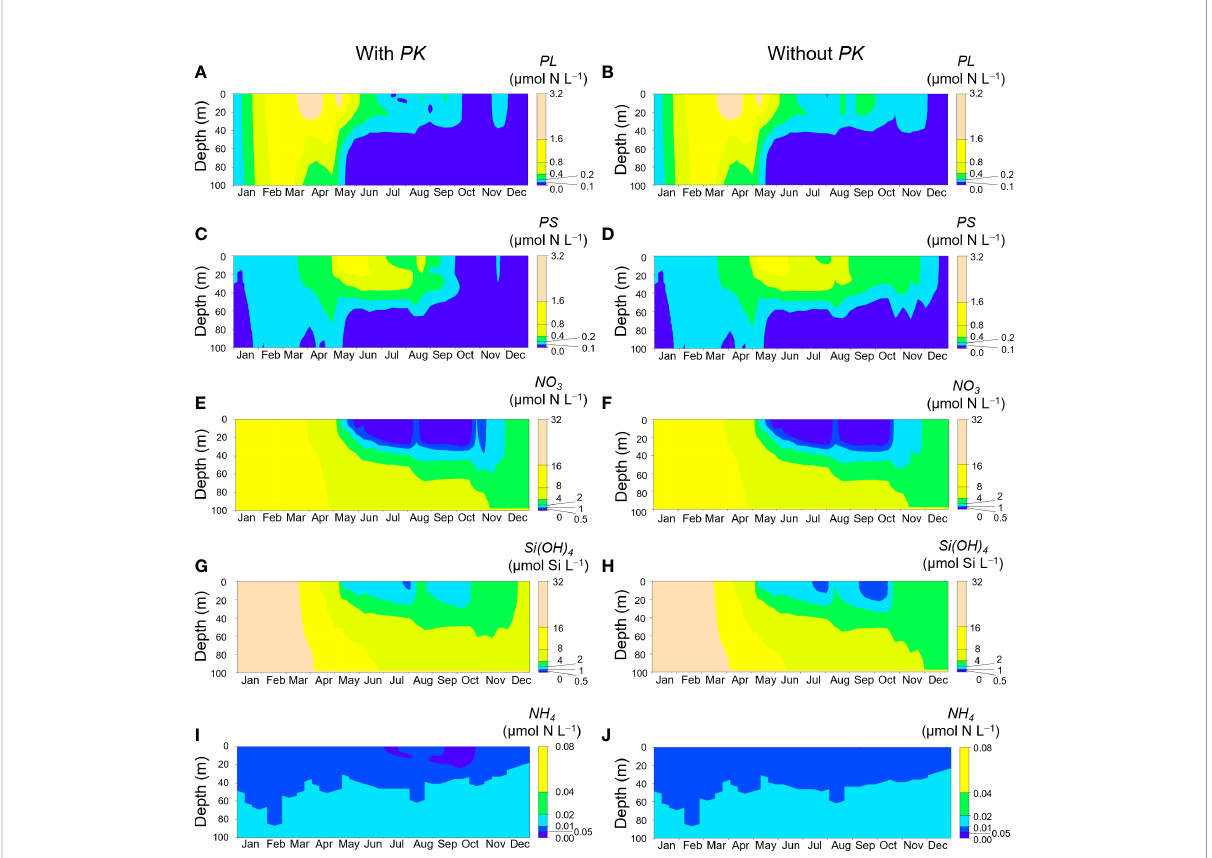
rejection of PK by zooplanktons. We also conducted numerical experiments without reducing the grazing pressure and could not reproduce the PK outbreak during late September to early November (our unpublished data). The reduction of grazing pressure was employed on the basis of results from previous